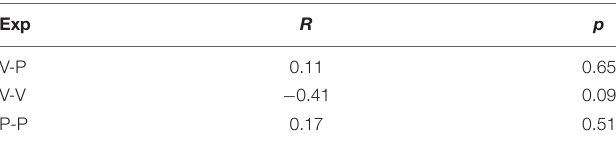
TABLE 2 | Coefficient of correlation R (and associated p-value) between the variability, RMSd, and visual dependency, ω V , in the Seated condition of the three experiments (Exp).